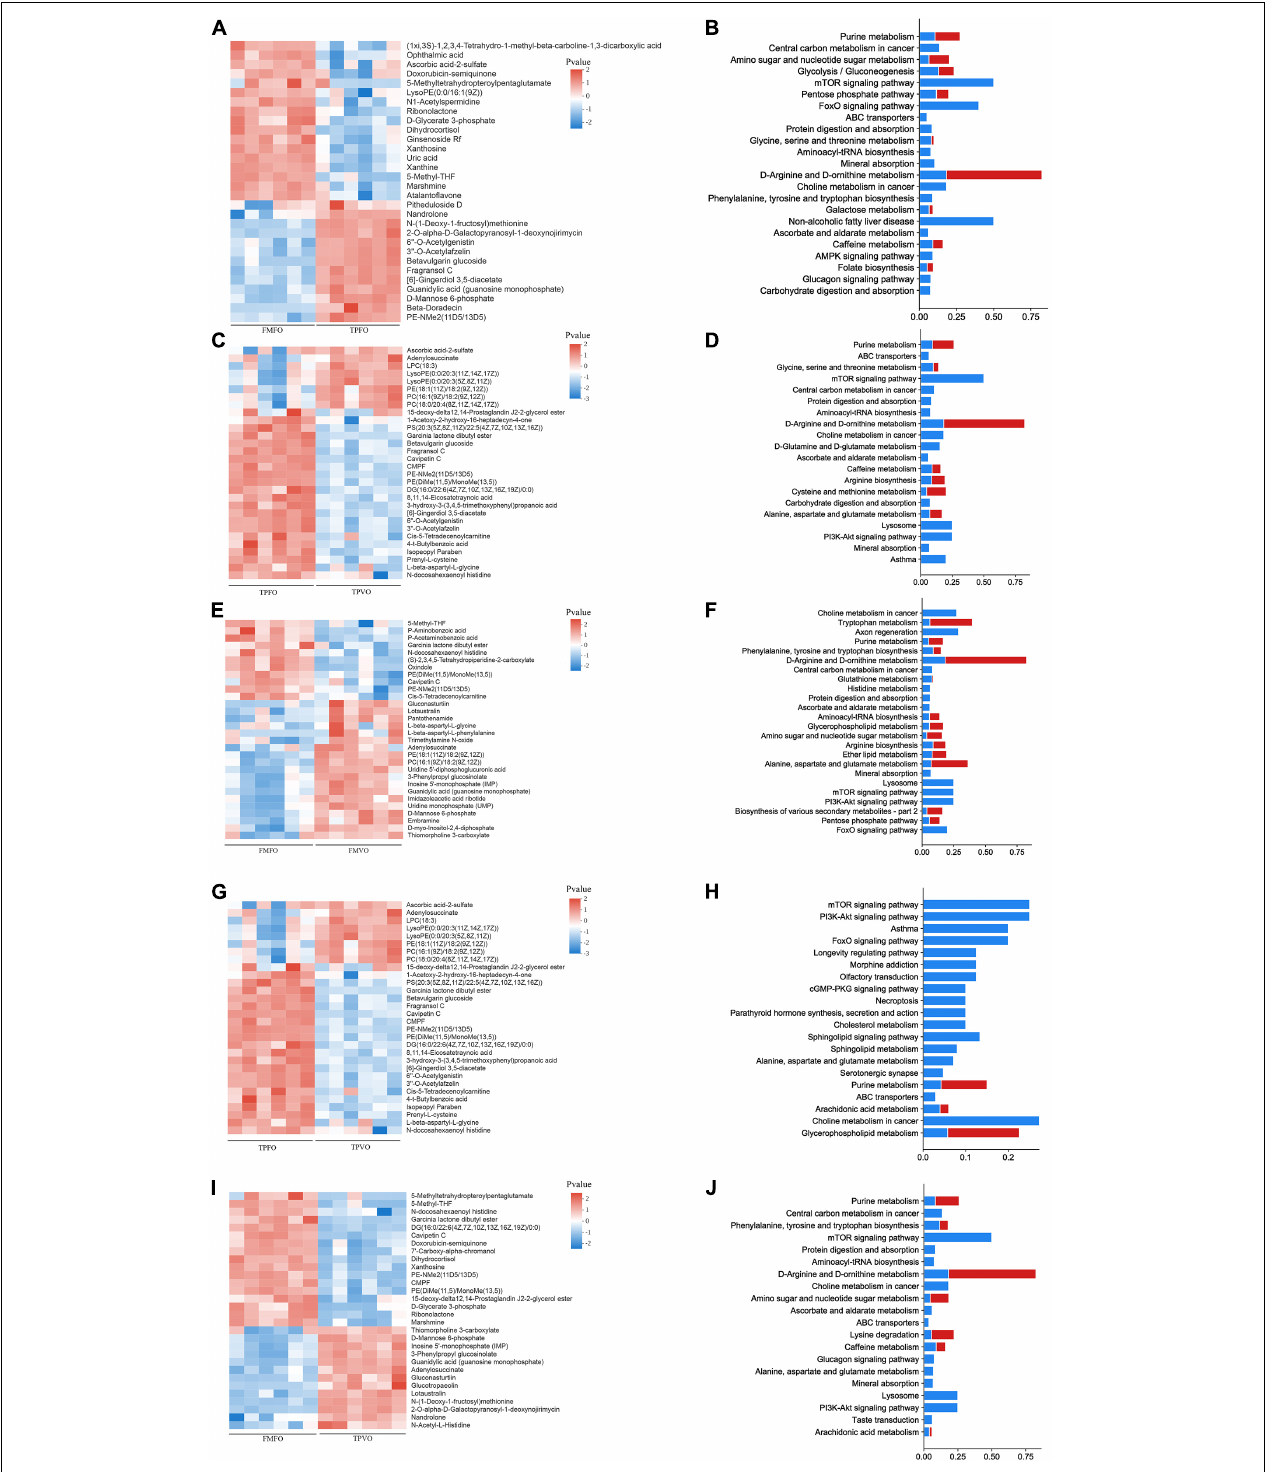
FIGURE 2 | Metabolomic profiles of O. mykiss fed diets with replacement of FM and/or FO. Heatmaps and pathway analysis plots of DMs in FM replacement (A–D) , FO replacement (E–H) , and combined replacement of FM and FO (I,J) . The blue bar in pathway analysis plots showed enrichment ratio and the red bar showed pathway impact value calculated from pathway topology